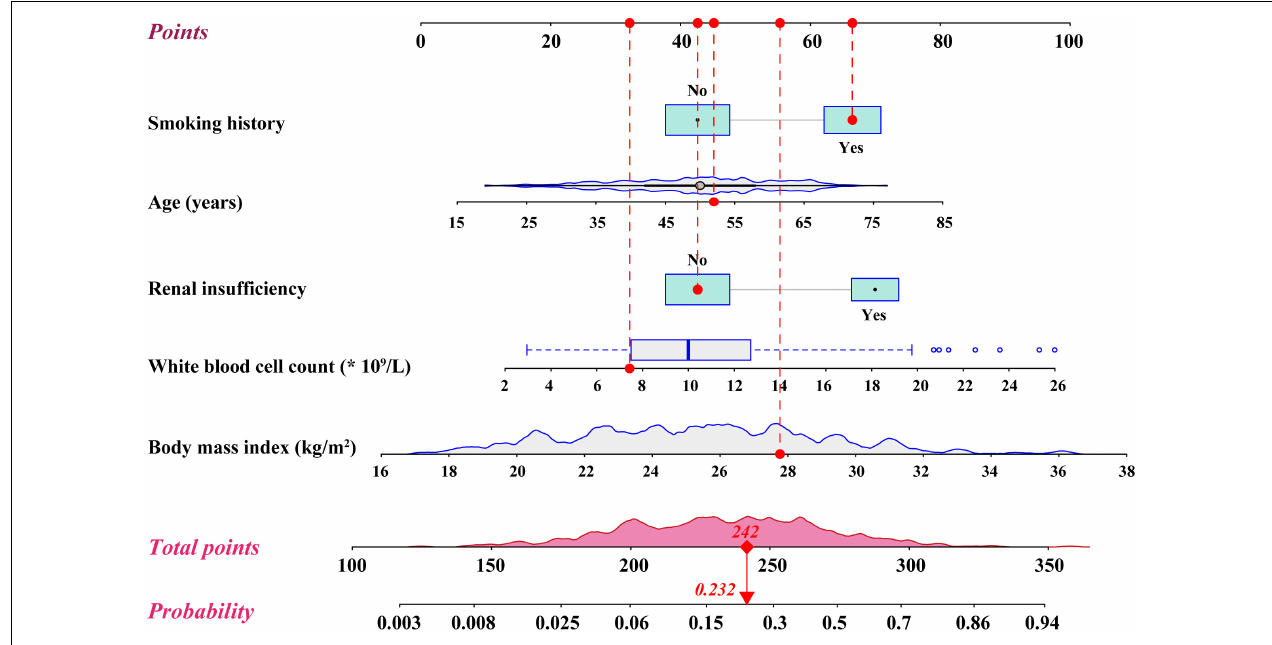
FIGURE 2 | Nomogram for the prediction of severe hypoxemia in patients undergoing Stanford type A acute aortic dissection surgery.